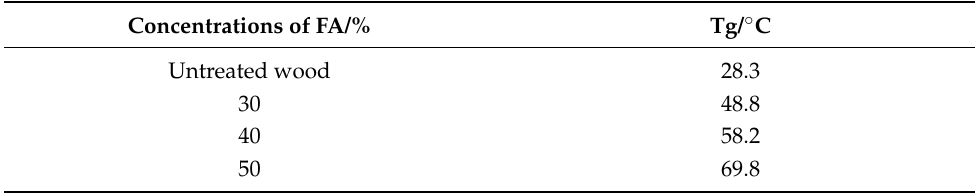
Table 2. Glass transitions at different